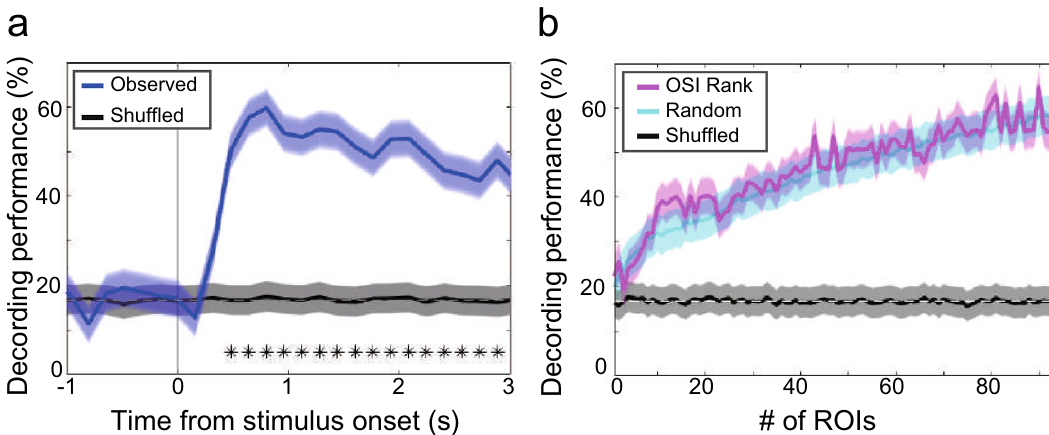
Figure 7. Decoding the orientation of presented stimuli. ( a ) Orientation decoding performance before and after stimulus presentation using ROIs detected from V1 in the three hemispheres. The blue and black lines represent the decoding performances using the observed and shuffled data, respectively. Asterisks indicate significant differences between the results from observed and shuffled data (α < 0.00001). Error areas: standard error of the mean. ( b ) Performance when the number of ROIs used for decoding is increased. Magenta represents the case where ROIs are selected from high to low OSI values. Cyan represents the case where ROIs are randomly selected from observed data. Black represents the case where ROIs are randomly selected from shuffled data. Error areas: standard error of the